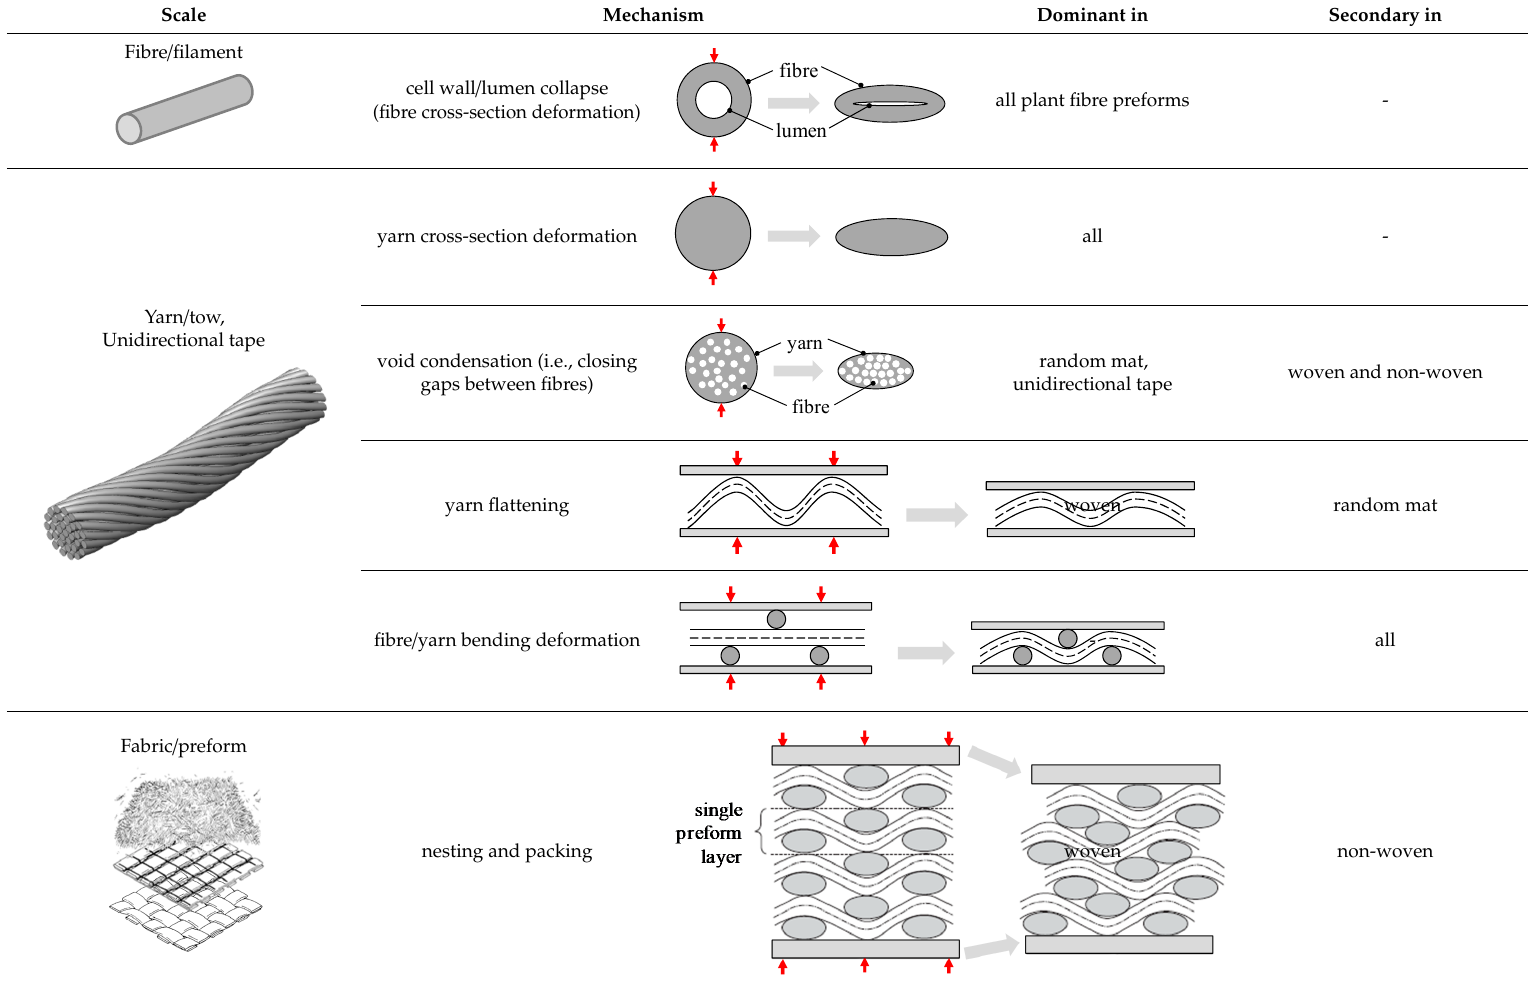
Table 1. The dominant and secondary compaction mechanisms at the fibre, yarn, and fabric scales in random mat, non-woven, and woven preforms. Scale Mechanism Fibre/filament lumenfibre (fibre cross-section deformation)